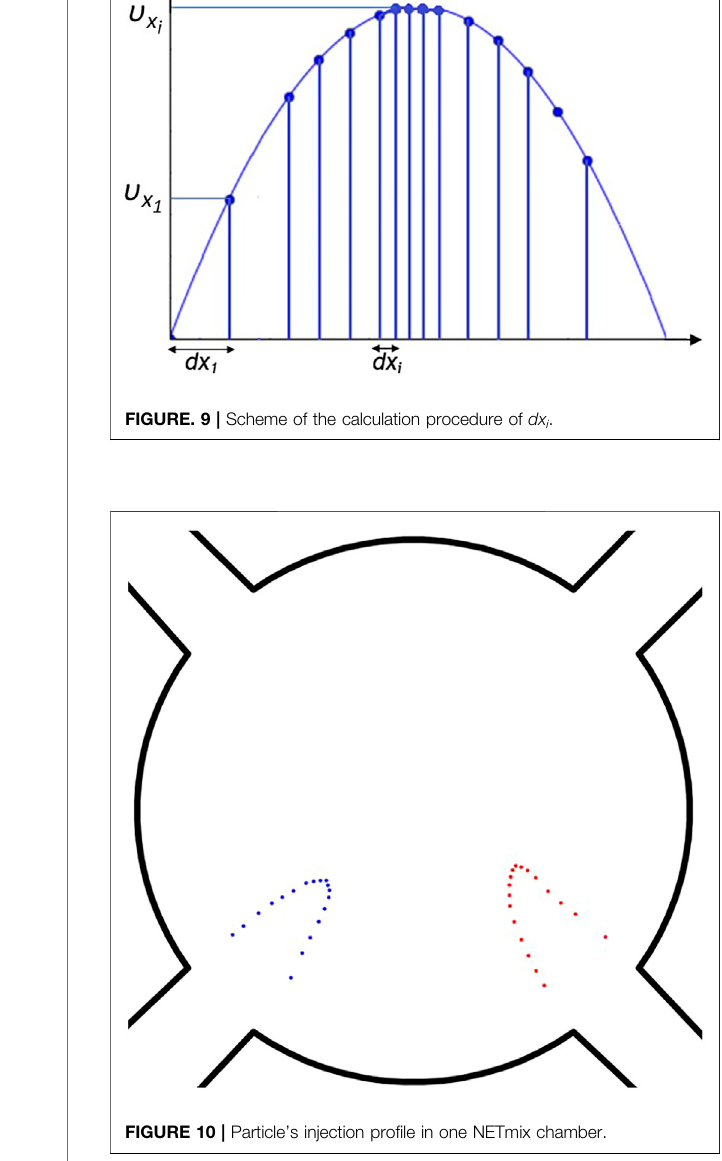
FIGURE 10 | Particle ’ s injection pro fi le in one NETmix